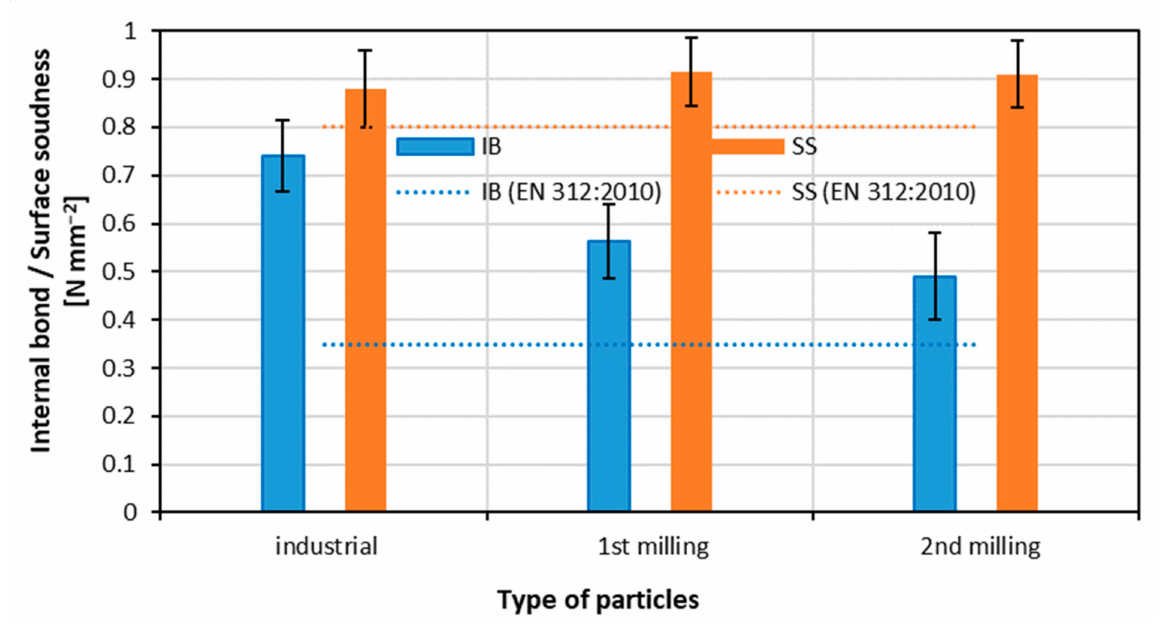
Figure 4. Internal bond and surface soundness of panels produced with different particles.